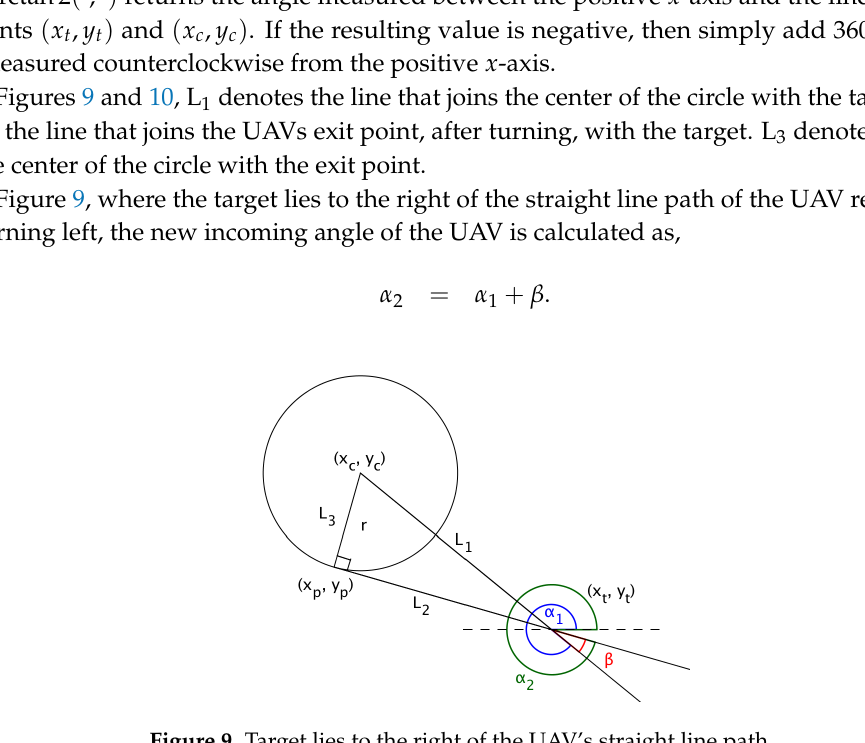
Figure 9. Target lies to the right of the UAV’s straight line path.